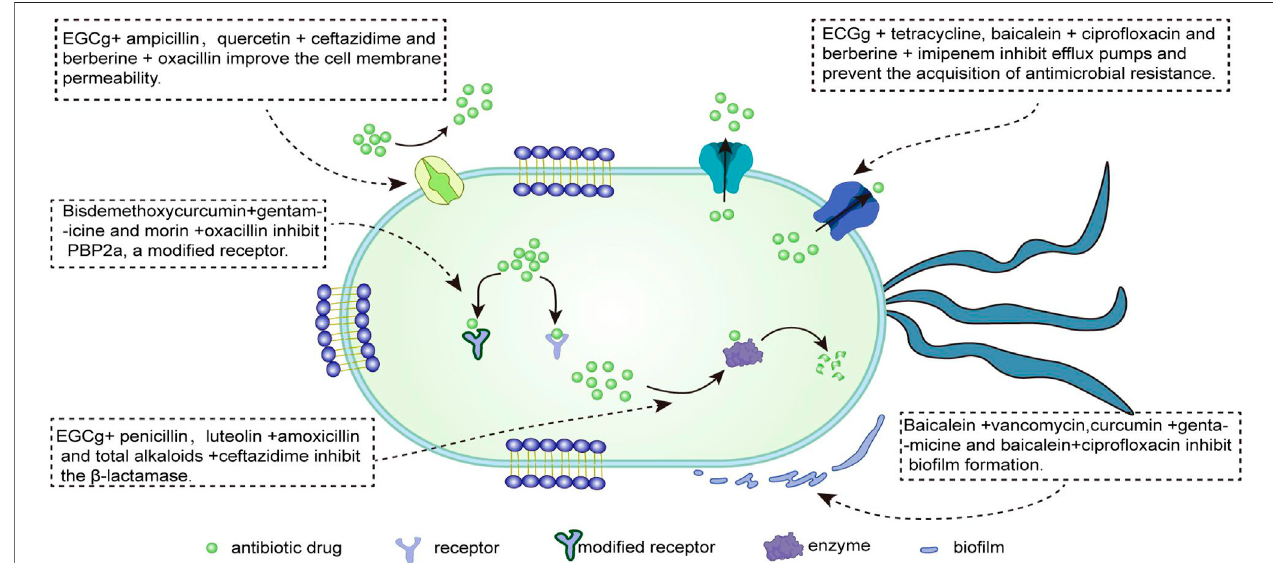
FIGURE 2 | The major mechanism and target of the antibacterial effect of antibiotics combined with active ingredients of traditional Chinese medicine.